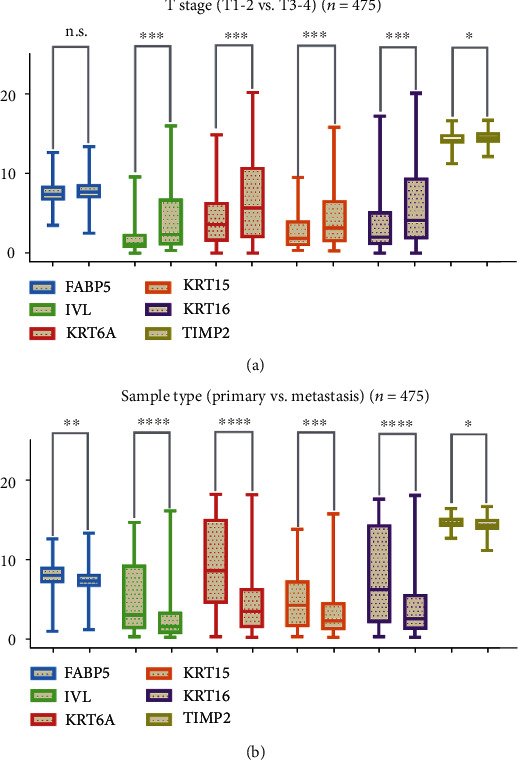
(a) Except FABP5, elevated expression patterns of IVL, KRT6A, KRT15, KRT16, and TIMP2 were significantly associated with T stage (T1-T2 vs. T3-T4) (n = 475). (b) Six hub genes are highly expressed in primary than metastatic sites (n = 475) (FABP5 presents in light blue, IVL in light green, KRT6A in red, KRT15 in orange, KRT16 in purple, and TIMP2 in dark green).